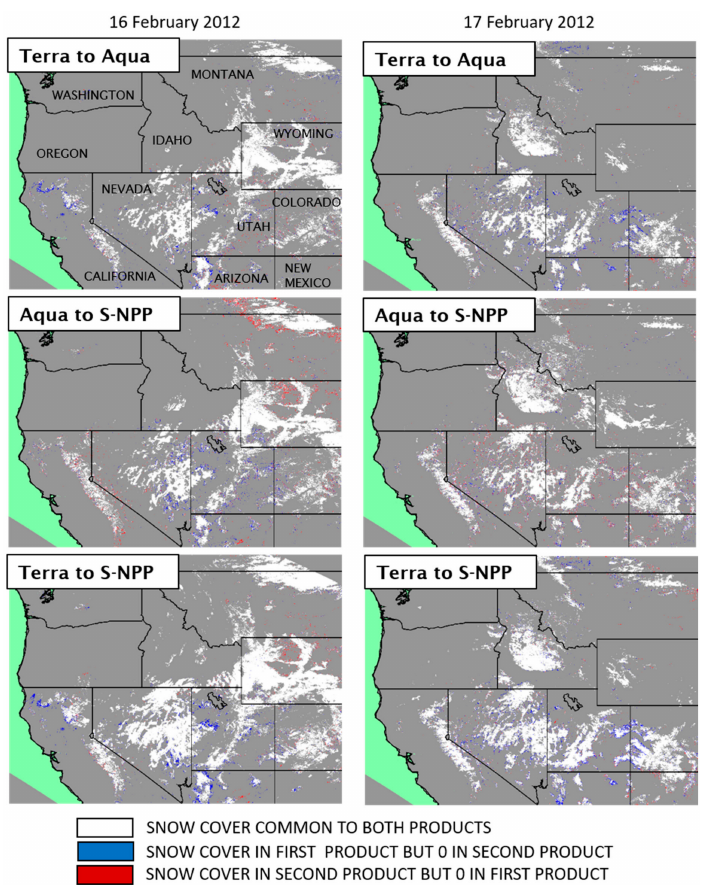
Figure 12. Comparison of SCE products at 1 km grid resolution for the western United States on 16 February and 17 February 2012. Paired comparisons—Terra to Aqua top row, Aqua to S-NPP center row, and Terra to S-NPP bottom row. Table 3. Paired SCE CMG comparison statistics for the western United States. Clear only observations in both products were compared. The percentages are based on the count of SCE cells in one product and snow free land (SCE = 0), and in the other as a percentage of snow cover common to both products. Paired